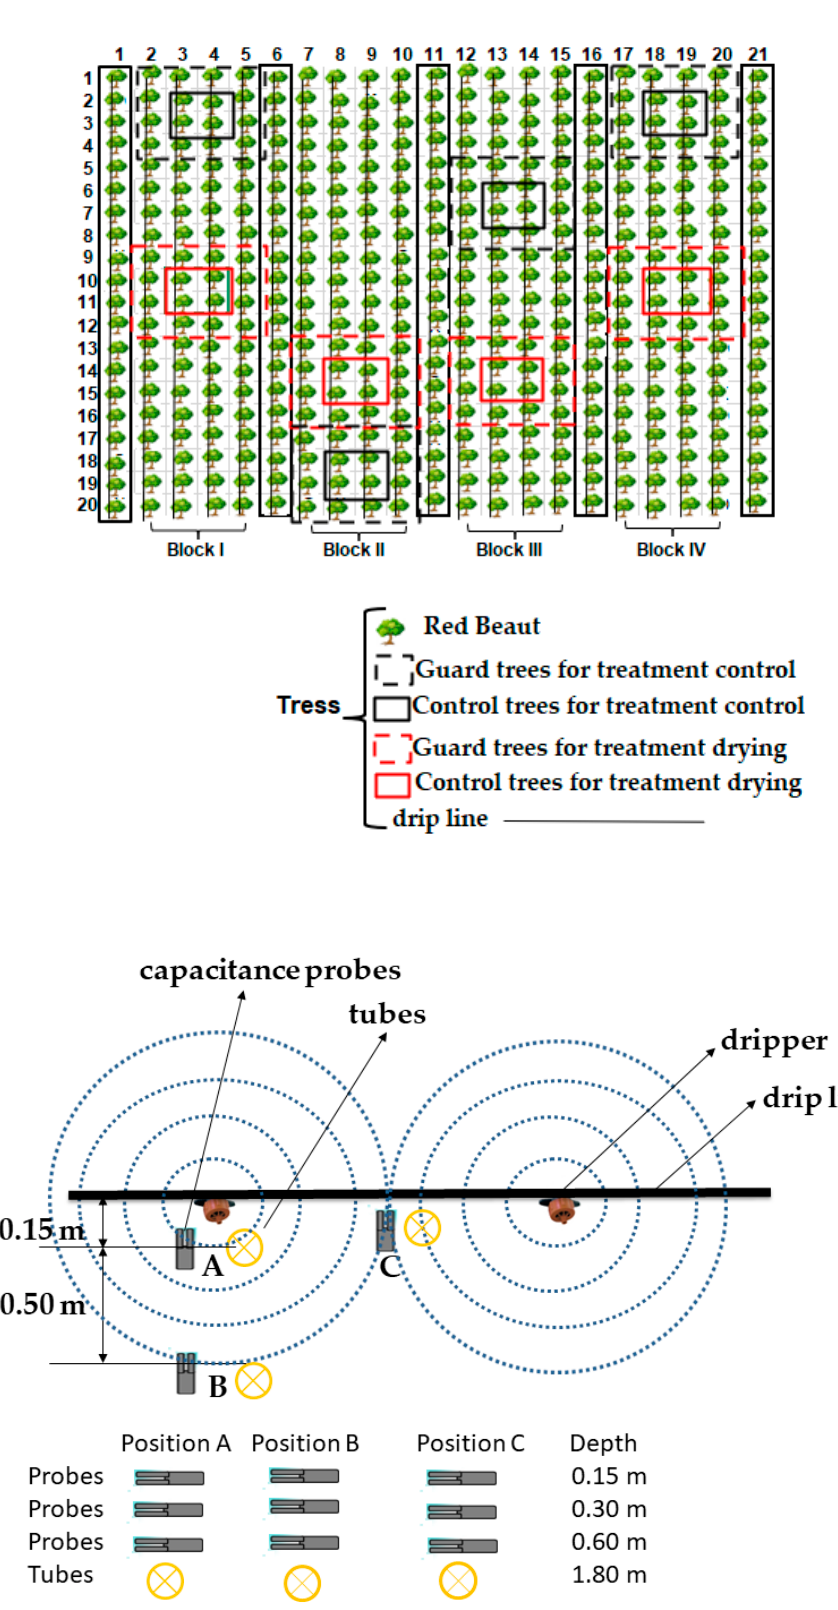
Figure 1. ( a ) Experimental design of the plot and ( b ) Localization of the neutron probe tubes and capacitance probes in the different positions and depths.